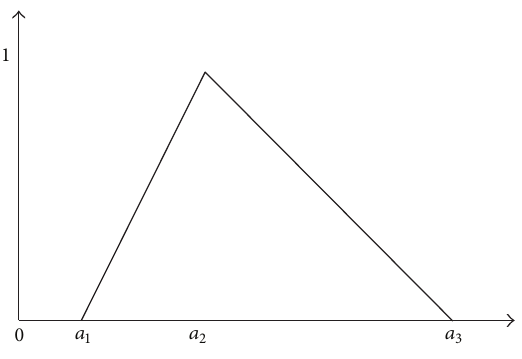
Figure 1: Membership functions of